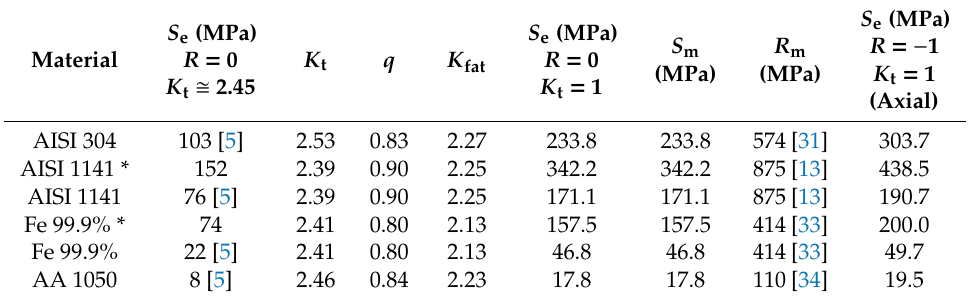
Table A1. Simulation-based S e values of the investigated materials (revised with the new results for the steel AISI 1141 and for the Fe 99.9%, marked with *, see Section 3 for more details) translated to the case of an unnotched sample ( K t = 1) and of purely alternating stress ( R = − 1).